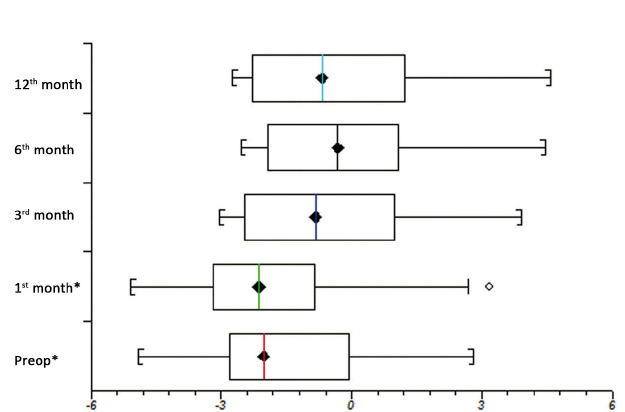
Fig. 1 - Evolution of median z-scores for weight/age (WAZ) in the group of cardiac patients. Analysis of variance with P=0.081. (*) The WAZ was significantly lower when compared with the general population’s in the preoperative period and the first month